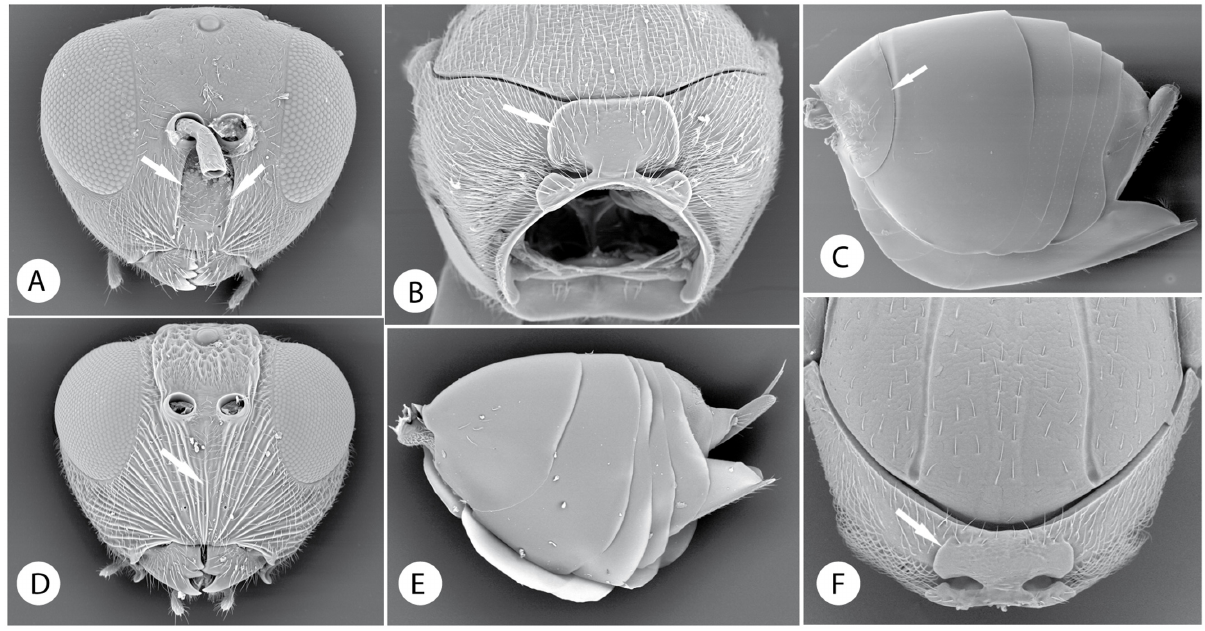
Fig 14. Morphological characters of Ceroptresini, Synergini, Phanacidini and Aulacideini. Ceroptres clavicornis Hartig: A) head in anterior view. B) pronotum in anterior view. C) metasoma in lateral view. D) head in anterior view of Synergus ibericus . E) metasoma in lateral view of Phanacis helminthiae (Stefani). F) pronotum in anterior view of Liposthenes kerneri (Wachtl).